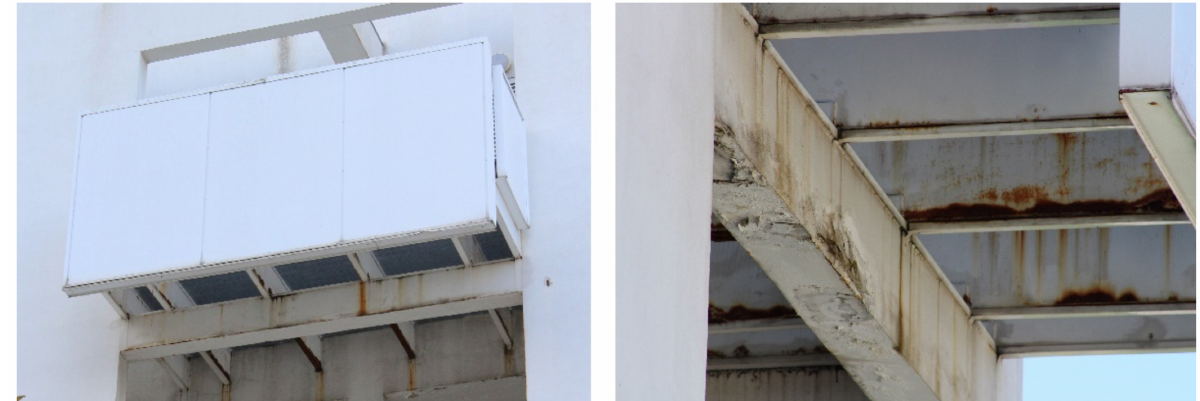
Figure 2. Jubilee Church, Rome (2003). Rusted steel components (ph. Cardellicchio,